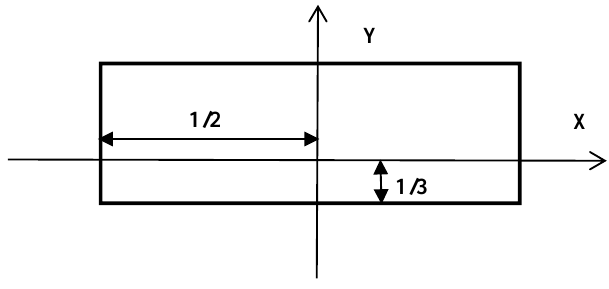
Figure 2. X-direction and Y-direction in the samples.